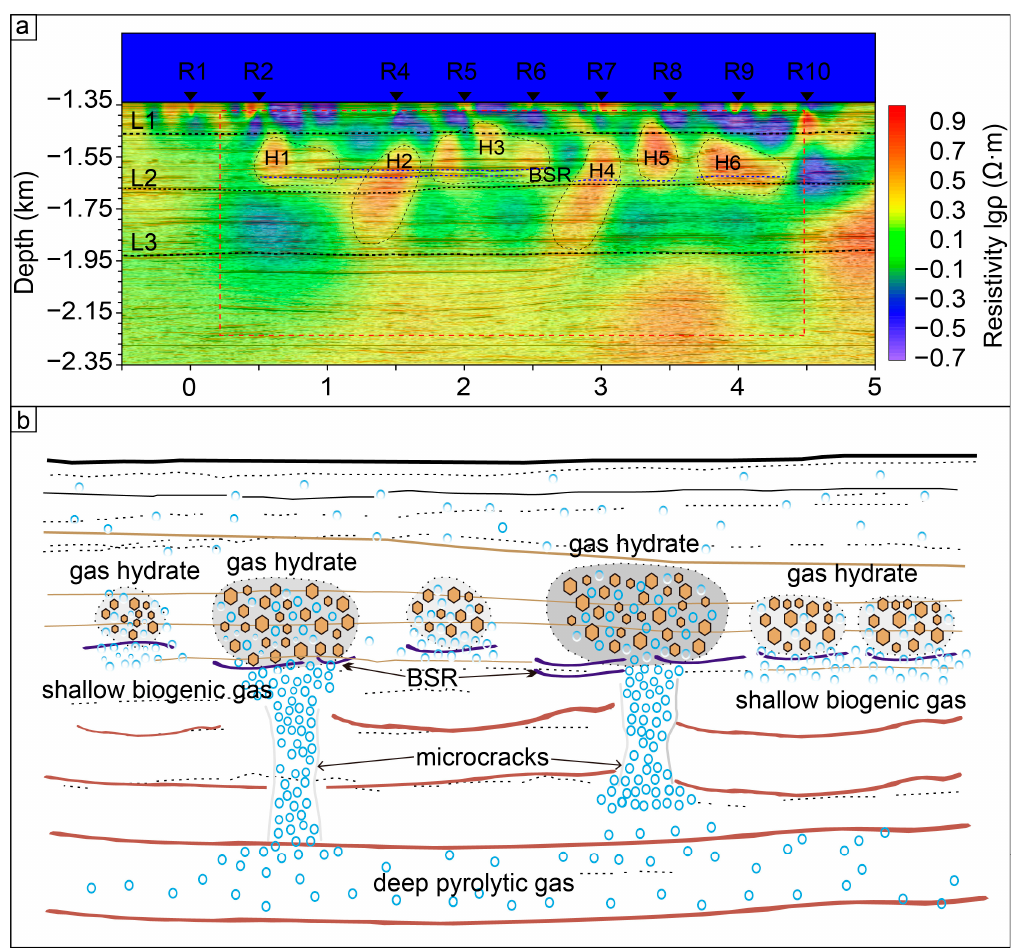
Figure 10. Resistivity structure and schematic diagram of gas hydrate migration and accumulation: ( a ) Resistivity structure in the study area; ( b ) Schematic diagram of gas hydrate migration and accumulation, highlighting the anomalous resistivity in the corresponding region (red and dotted line areas).